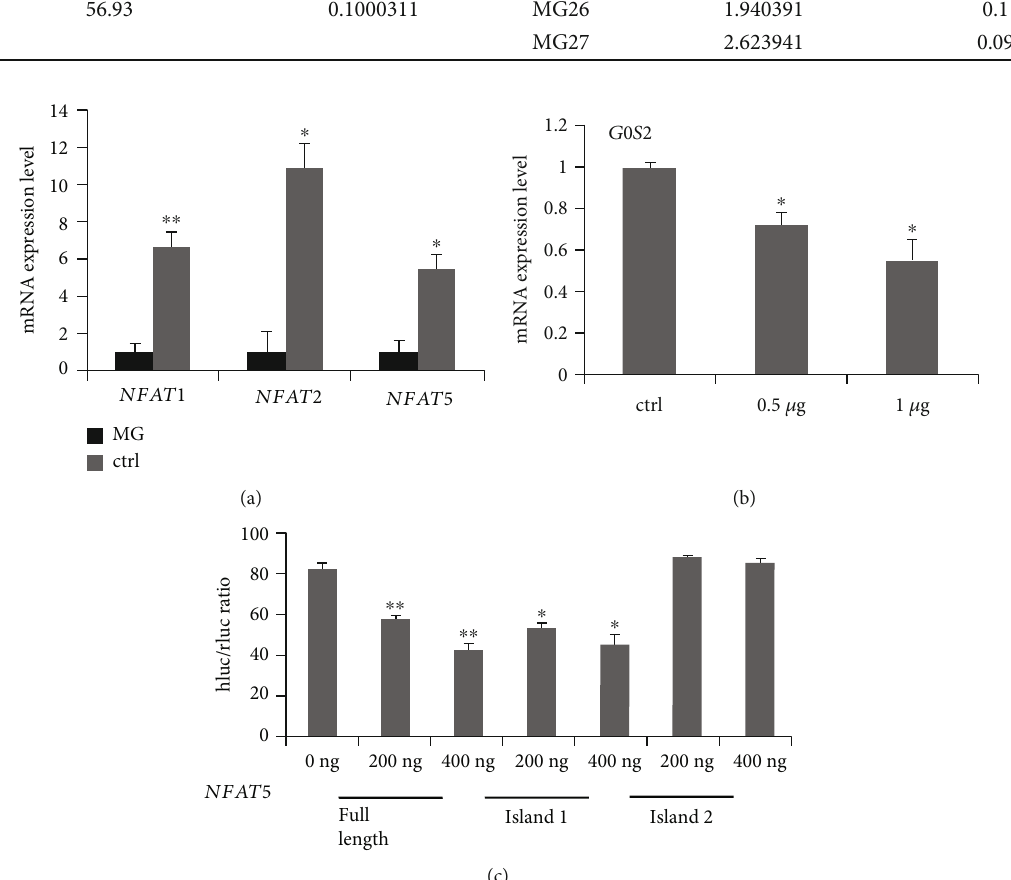
Figure 5: NFAT5 inhibit G0S2 expression through island 1. (a) The relative mRNA expression level of NFAT family in healthy human and MG patients. The y -coordinate represents the relative expression level, MG means the myasthenia gravis patients, and ctrl means healthy volunteers. (b) Upregulation NFAT5 inhibits G0S2 expression. The y -coordinate represents the relative expression level of G0S2; the x -coordinate represents the di ff erent concentrations P-EGF-N1-NFAT5 plasmid which were transfected into T cells. (c) NFAT5 binds island 1 of G0S2 promoter region detected by dual-Luciferase reporter. Full length represents the plasmid containing islands 1 and 2; islands 1 and 2 represent the plasmid containing the corresponding CpG island sequence from G0S2